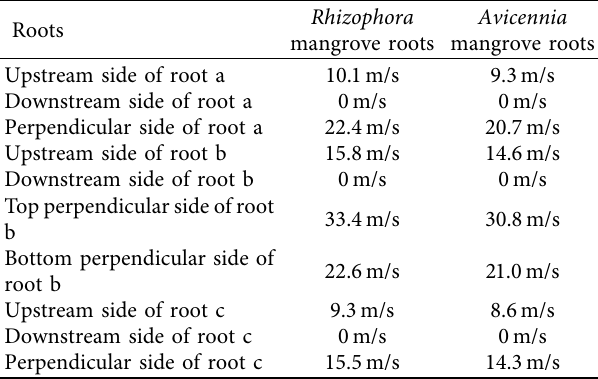
Table 2: Comparison of velocity of 3 different roots at different positions of incompressible unsteady air flow within 8 seconds.